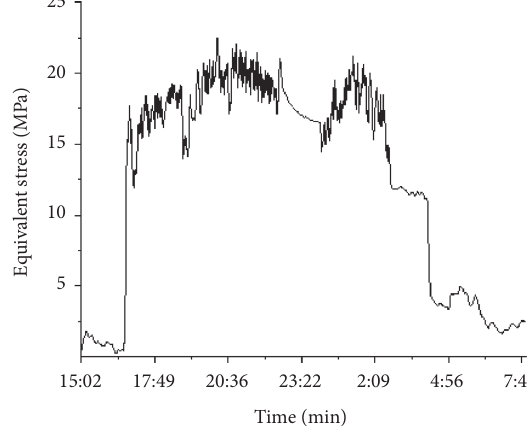
Figure 20: Equivalent stress curve of point